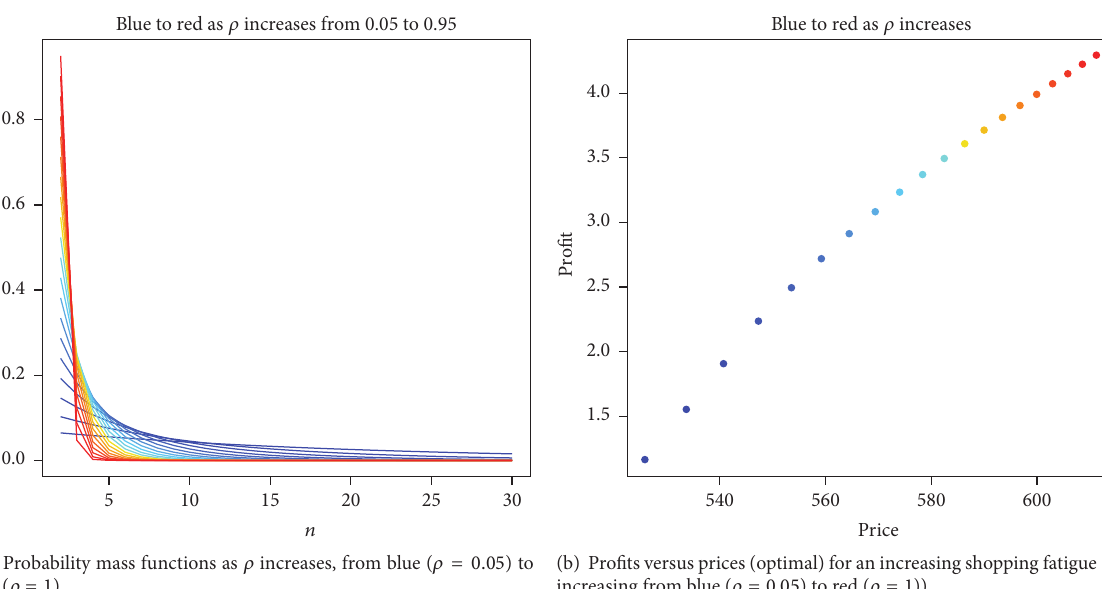
Figure 4: The seller’s problem under shopping fatigue. Main parameters in Table 3 and those used earlier as benchmark ( 𝜇 = 600, 𝜎 2 = = 0.15, 𝑁 = 30 125, ] = 2, 𝛼 𝑐